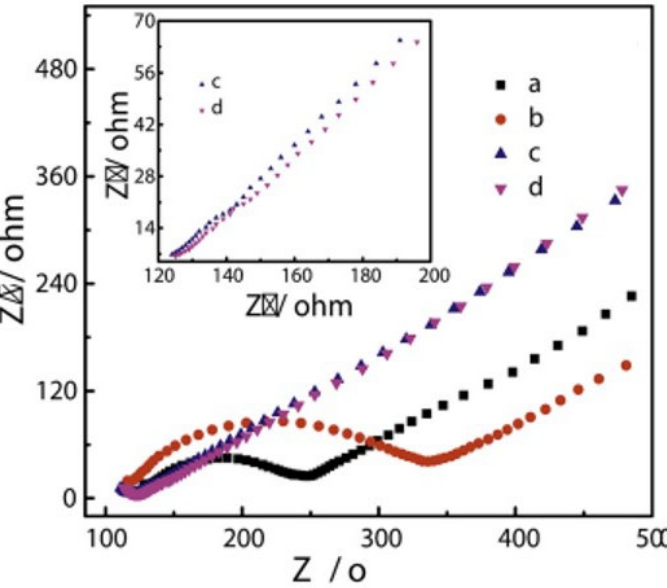
Figure 41. Nquist plots of bare GCE, Ti 2 C MXene/GCE. Reprinted with permission from [79]. Copyright 2021 Elsevier.